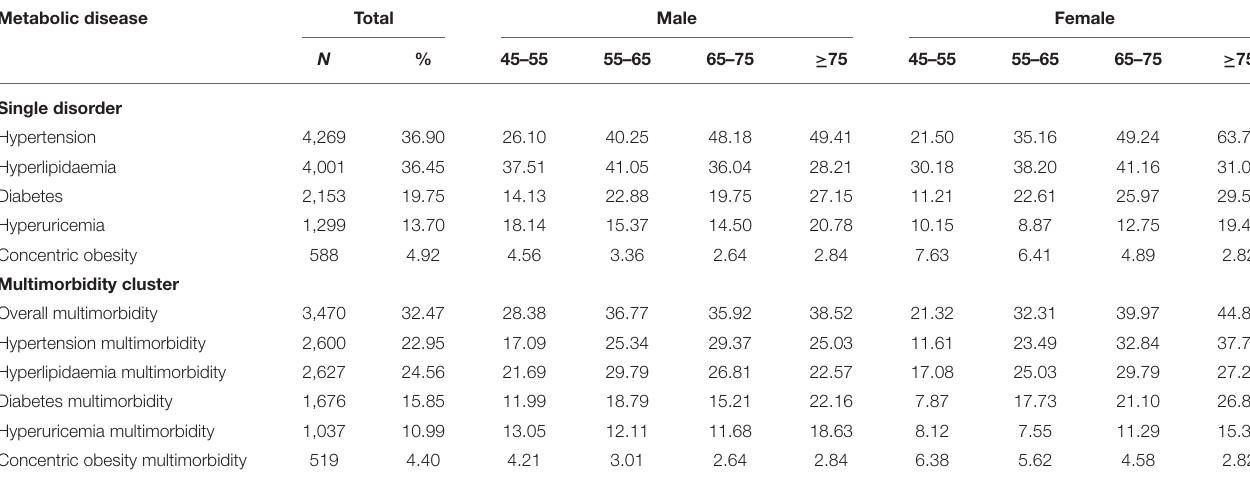
TABLE 2 | The proportion of metabolic diseases and multimorbidity among Chinese adults by gender and age group. Metabolic disease